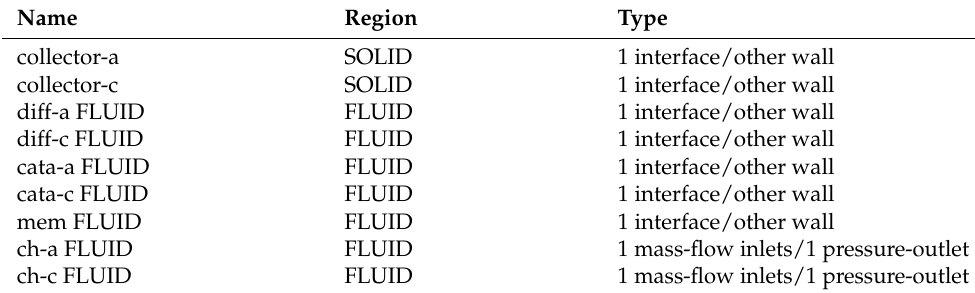
Table 2. Fluid region and boundary.